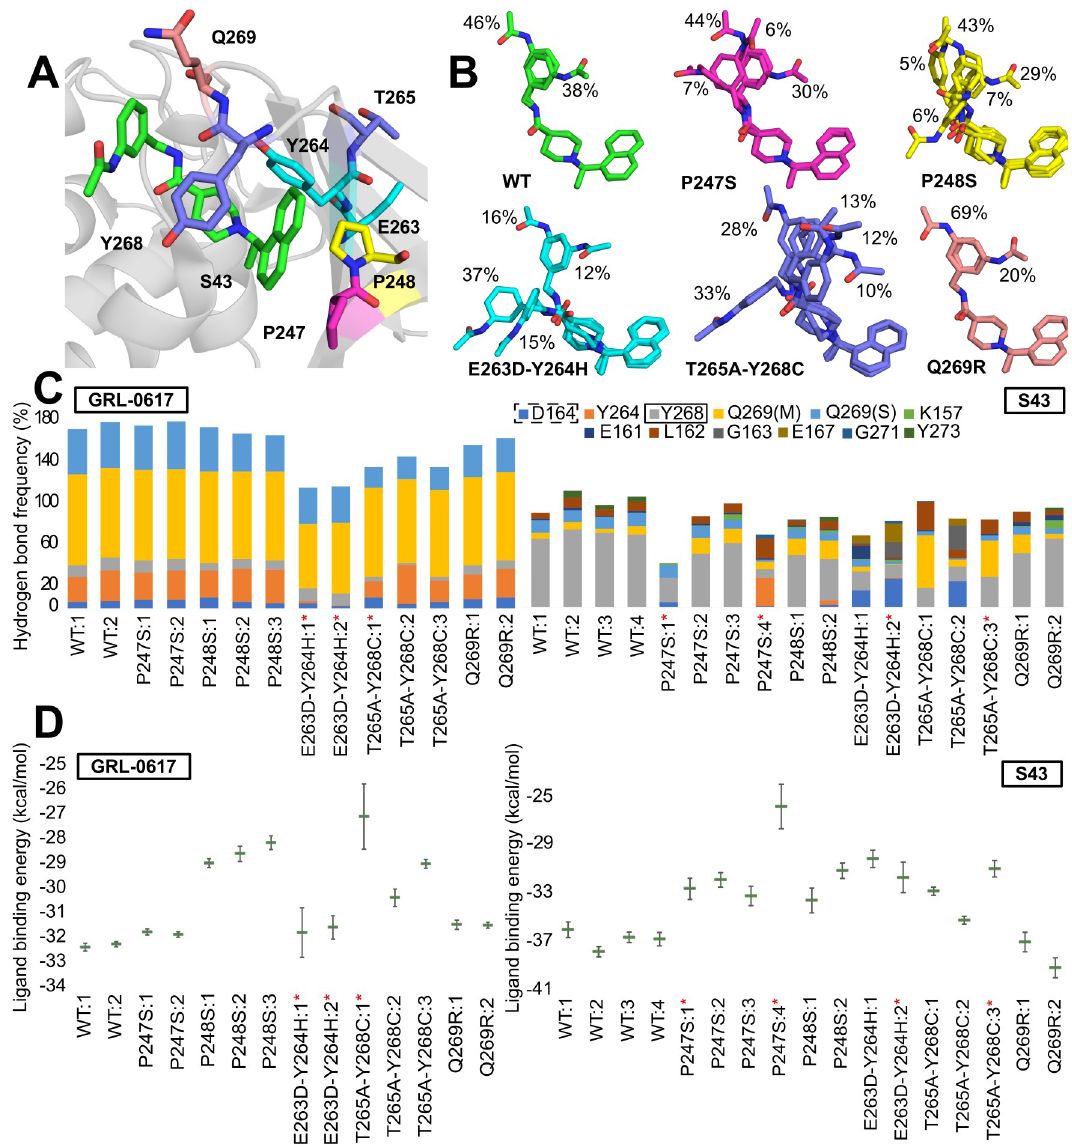
Fig 3. Selected variants found in PLpro. (A) Location of amino acids subject to mutation relative to the ligand (S43) binding site (based on PDB ID: 7d7t). (B) Representative S43 conformations bound to PLpro. Calculations are based on frames sampled every 100 ps from joint Molecular Dynamics trajectories. Conformations found in less than 5% of the frames are not shown for clarity. (C) Frequency of protein-ligand hydrogen bonds in different trajectories. Left: GRL-0617, right: S43. Calculations are based on frames sampled every 100 ps from Molecular Dynamics trajectories. Dashed rectangle points to the amino acid interacting via hydrogen bond with GRL-0617 in the crystal structure (PDB ID: 7jrn), the one with solid line with S43 (PDB ID: 7d7t). In the case of Q269 the ligand can bind to either its main chain (M) or side chain (S). The red asterisk indicates the trajectories in which the ligand dissociated from the binding site. (D) Ligands MMGBSA binding energy (kcal/mol) to PLpro. Left: GRL-0617, right: S43. Calculations are based on frames sampled every 100 ps from Molecular Dynamics trajectories—the averages and standard errors are shown. The trajectories in which the ligand dissociated from the binding site are marked with red